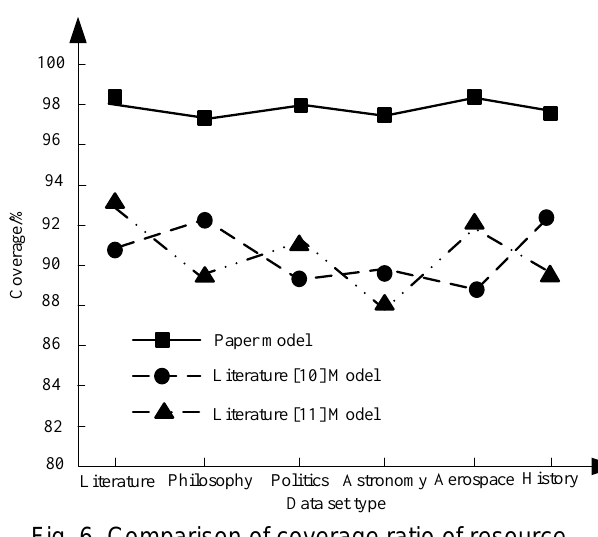
Fig. 6. Comparison of coverage ratio of resource